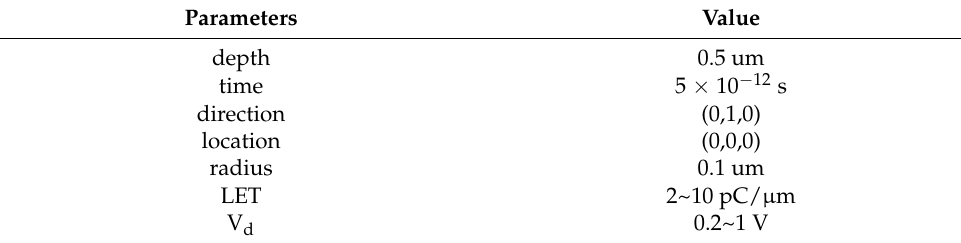
Table 2. Heavy-ion model parameters used for the